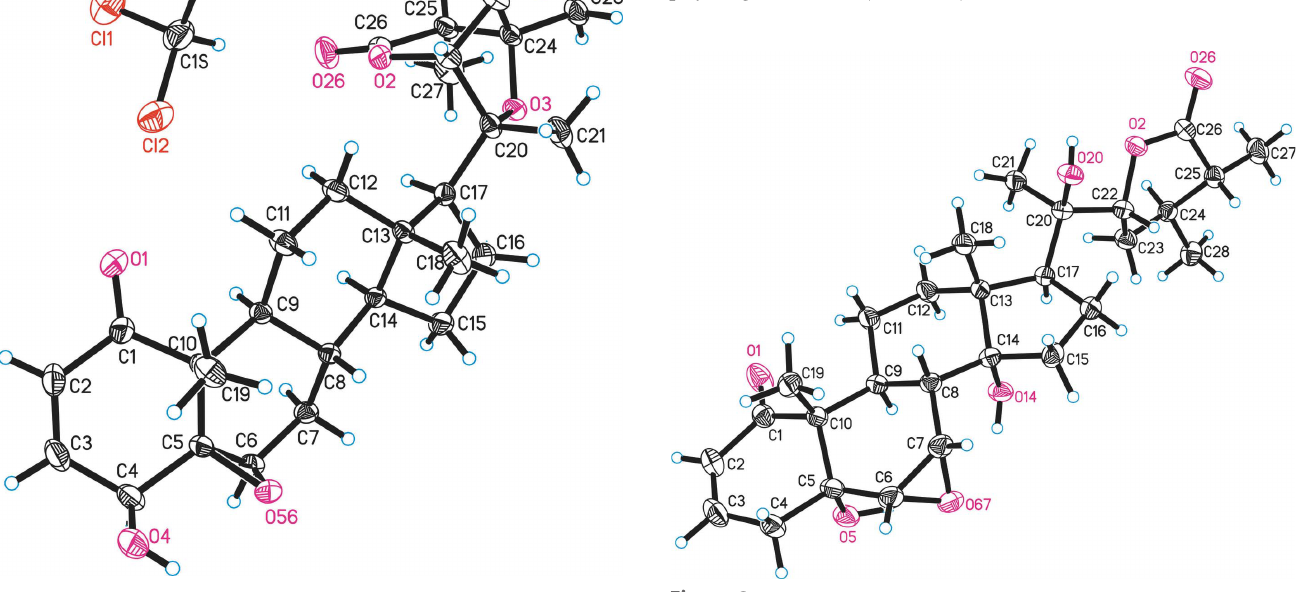
Figure 1 Molecular structure of the chloroform solvate of physangulide B (compound I ), including atom labelling. Displacement ellipsoids are drawn at the 30% probability level.